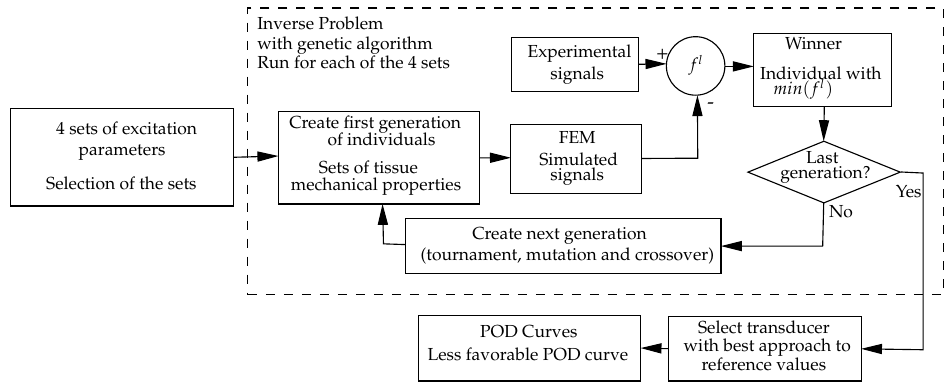
Figure 3. Calculation method for phase